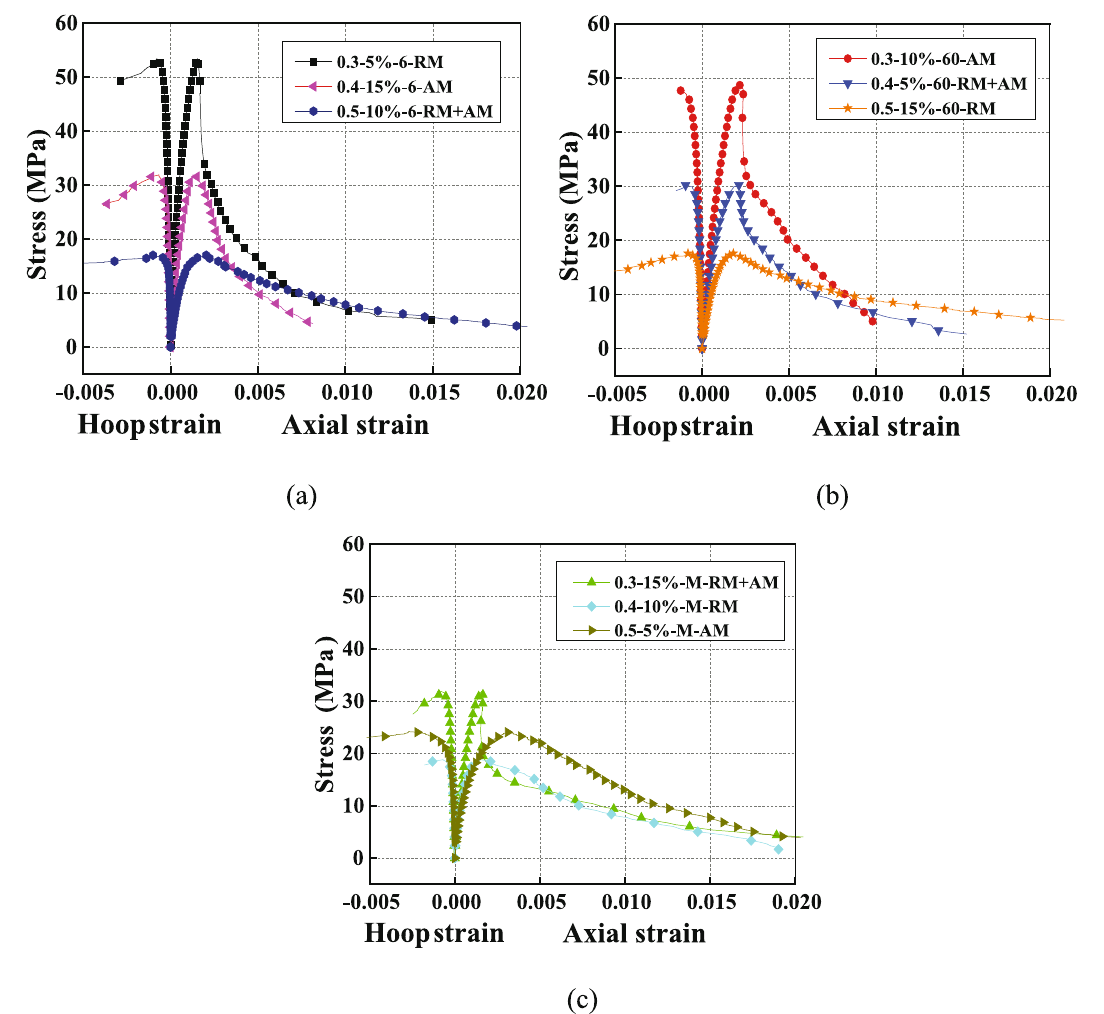
Figure 15: Stress – strain curve of RRAC with di ff erent rubber sizes: ( a ) 6 mesh rubber, ( b ) 60 mesh rubber, and ( c ) mixed - size